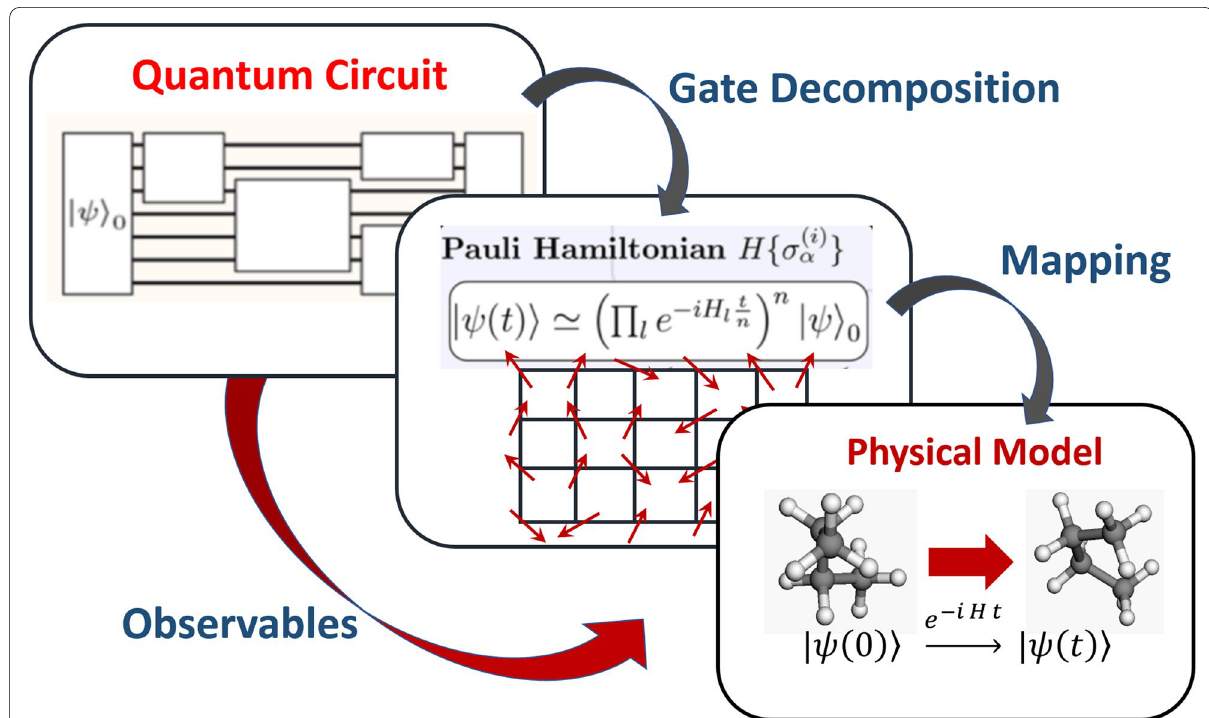
Fig. 6 Figure adapted from [267]. A conceptual illustration of how one might use Trotterization to perform a quantum simulation on a quantum computer. Given the physical problem of finding the evolution of a state under a Hamiltonian for a period of time, a mapping can be used to encode the relevant details of the problem into qubits on the quantum computer. Then, the encoded Hamiltonian can be sliced into many small steps according to the Suzuki–Trotter formula. By implementing the slices in succession, this gives an approximation for the time-evolved state as its output. By measuring the state on the quantum computer, approximate observables for the physical system can be